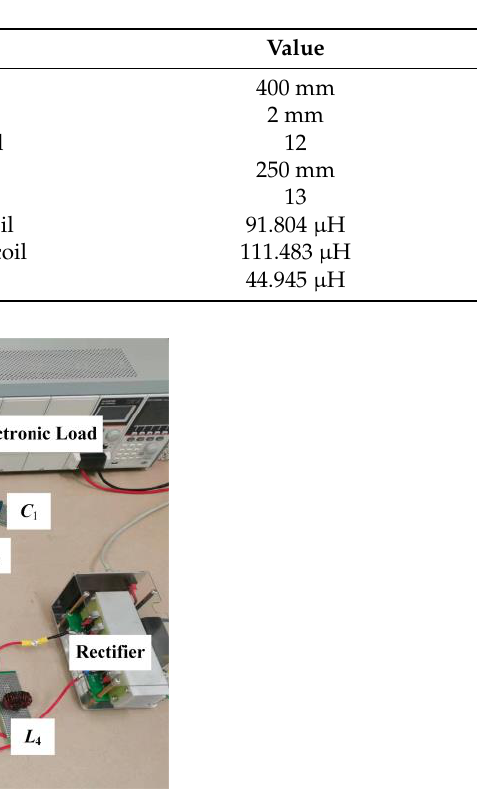
Figure 13. Experimental prototype. Table 4. Parameters of the compensating network.